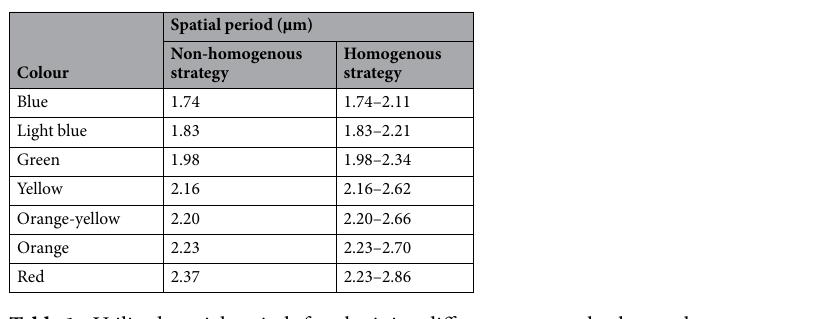
Table 1. Utilised spatial periods for obtaining different structural colours when a constant (non-homogeneous strategy) and variable (homogenous strategy for increasing the homogeneity of structural colours) spatial periods over the sample surface are used (at a viewing angle of 22° and height of 50 cm, for d values ranging from 0 to 40 mm).